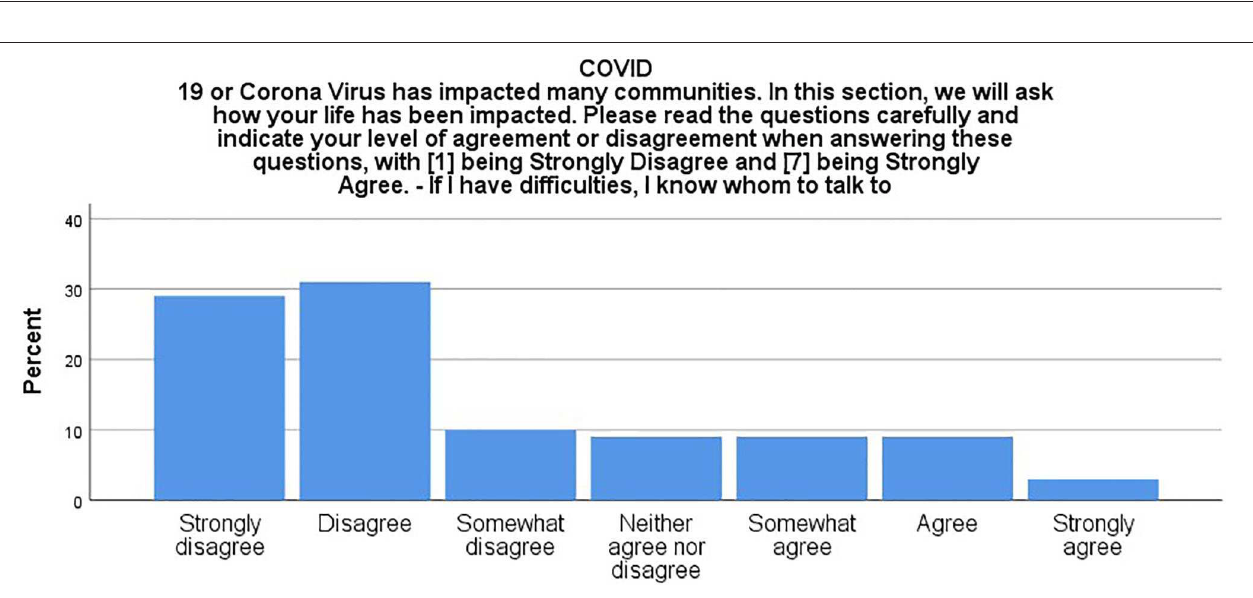
FIGURE 8 | Distribution of participants reporting knowledge of how to approach the MOM.